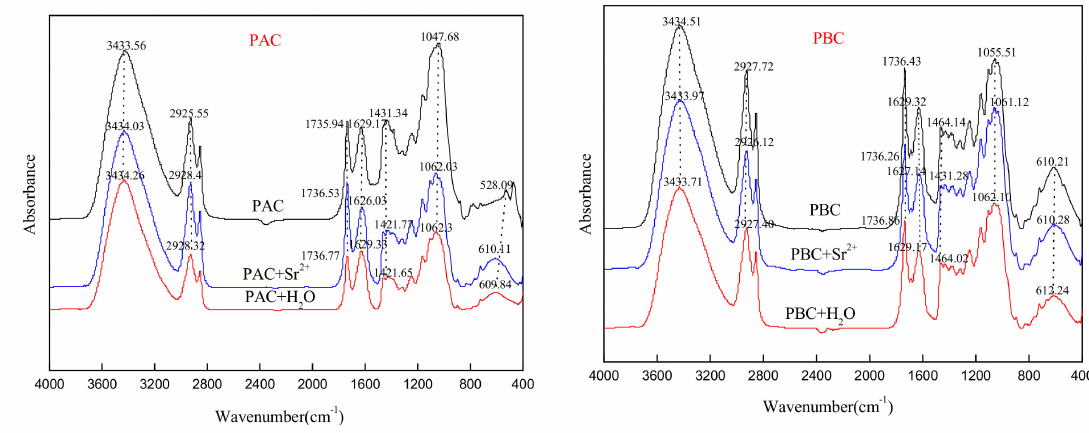
Figure 9. FTIR spectrometer of cuticle before and after Sr adsorption by adaxial (PAC) and abaxial (PBC) cuticle of Photinia serrulata